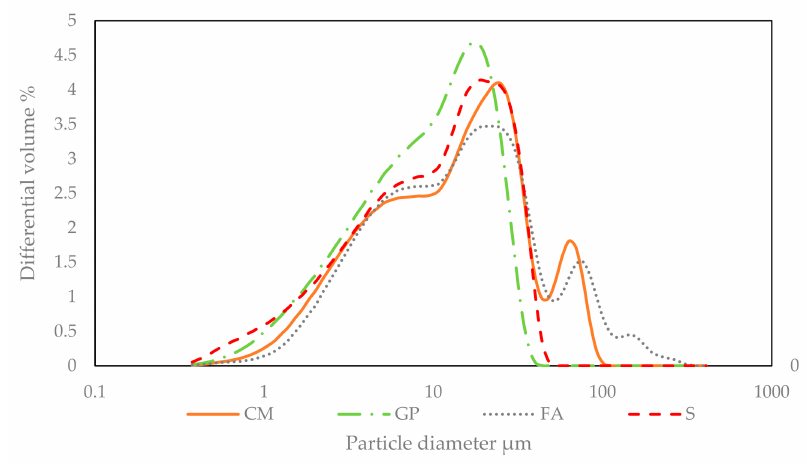
Figure 1. Particle size distribution. Table 1. Chemical compositions of raw materials obtained through XRF.